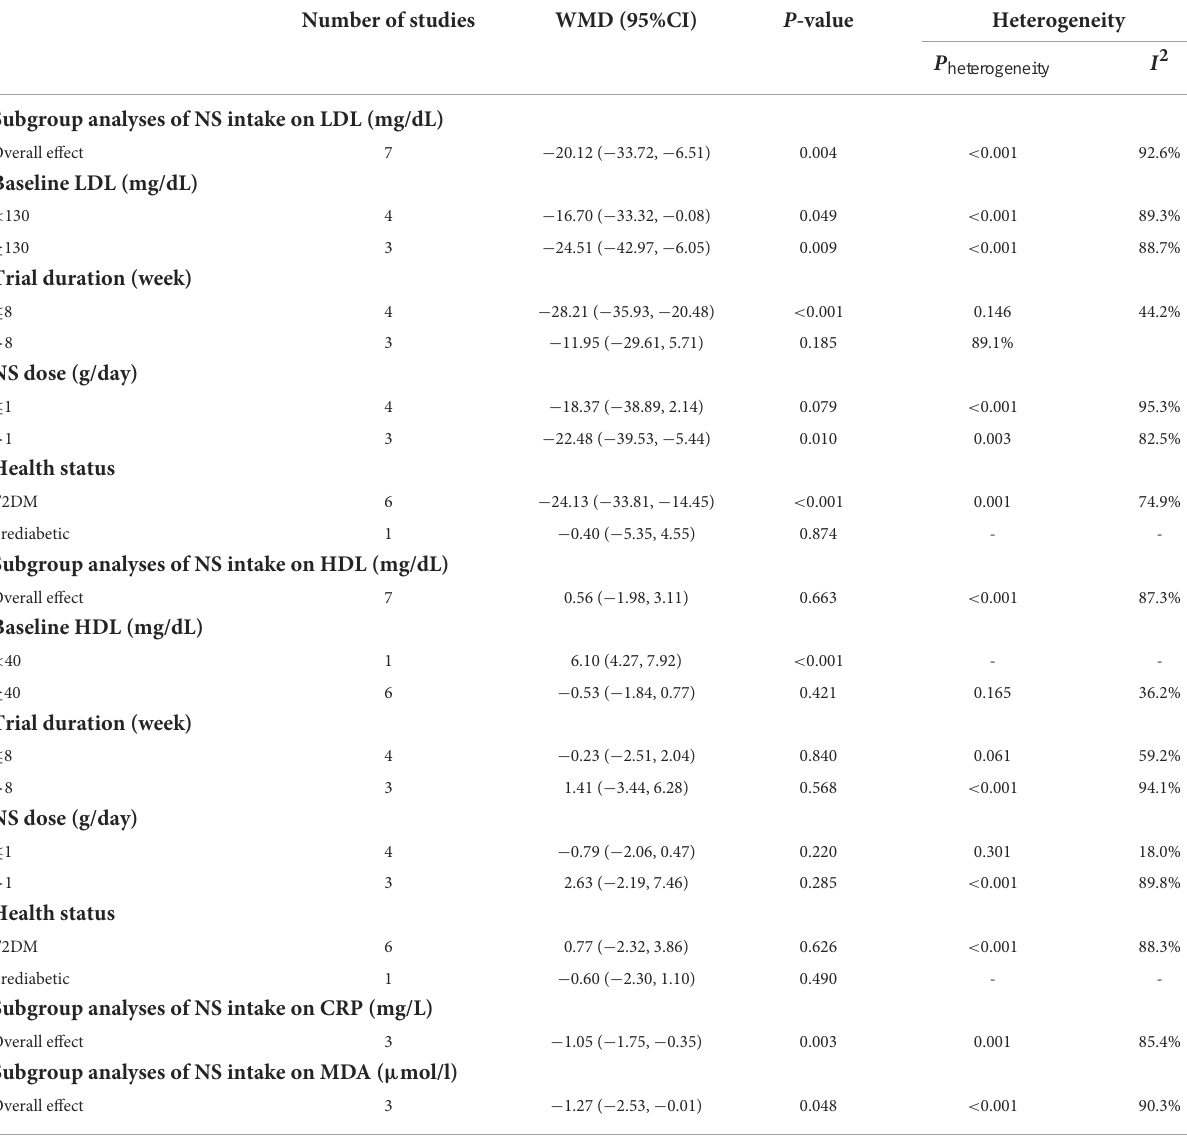
mg/dL; 95% CI: − 1.98, 3.11; P = 0.663; P heterogeneity < 0.001, I 2